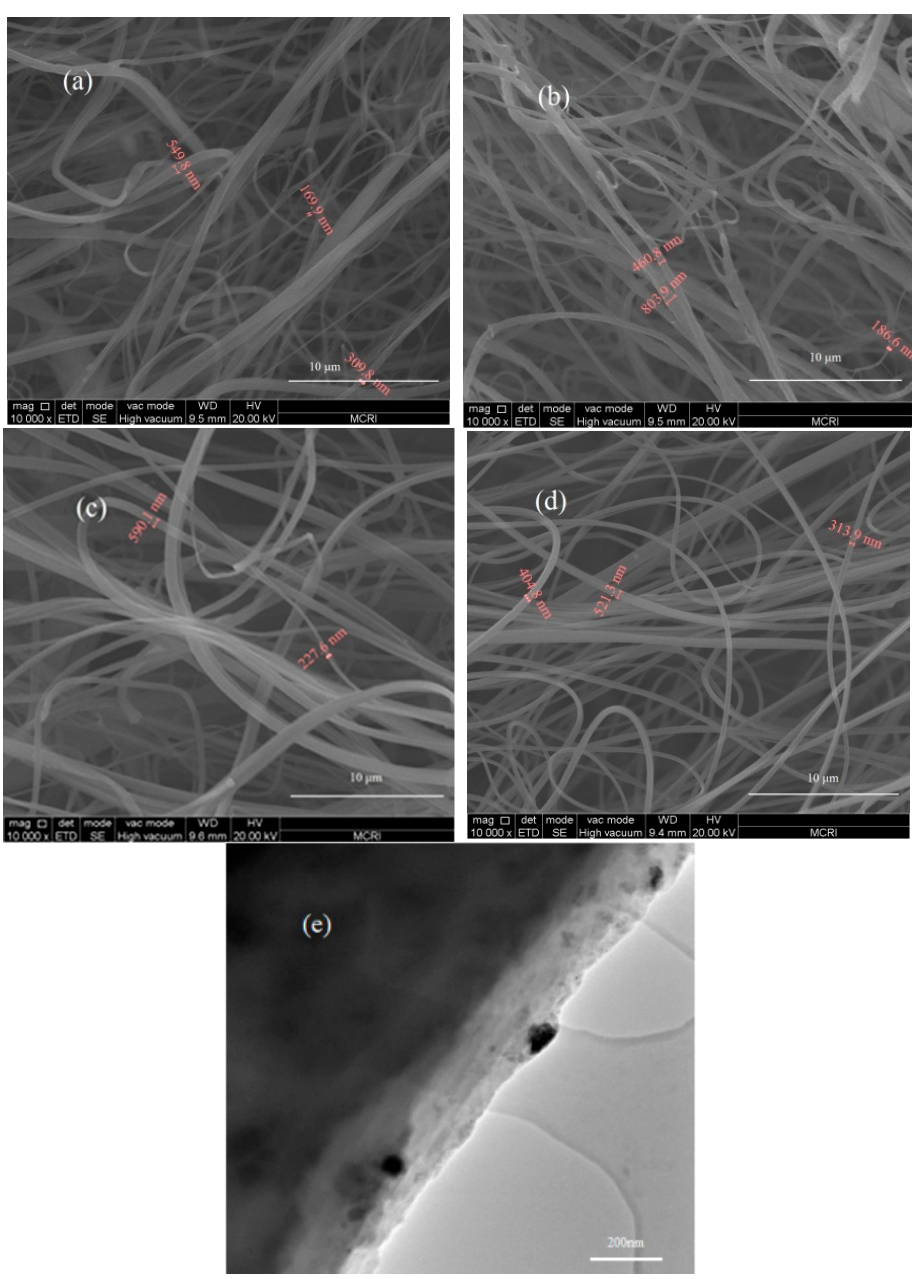
Figure 3. Images of electrospun NC-based composite fibers (( a – d ) SEM of samples 1, 2, 3, 4; ( e ) TEM of sample 3).